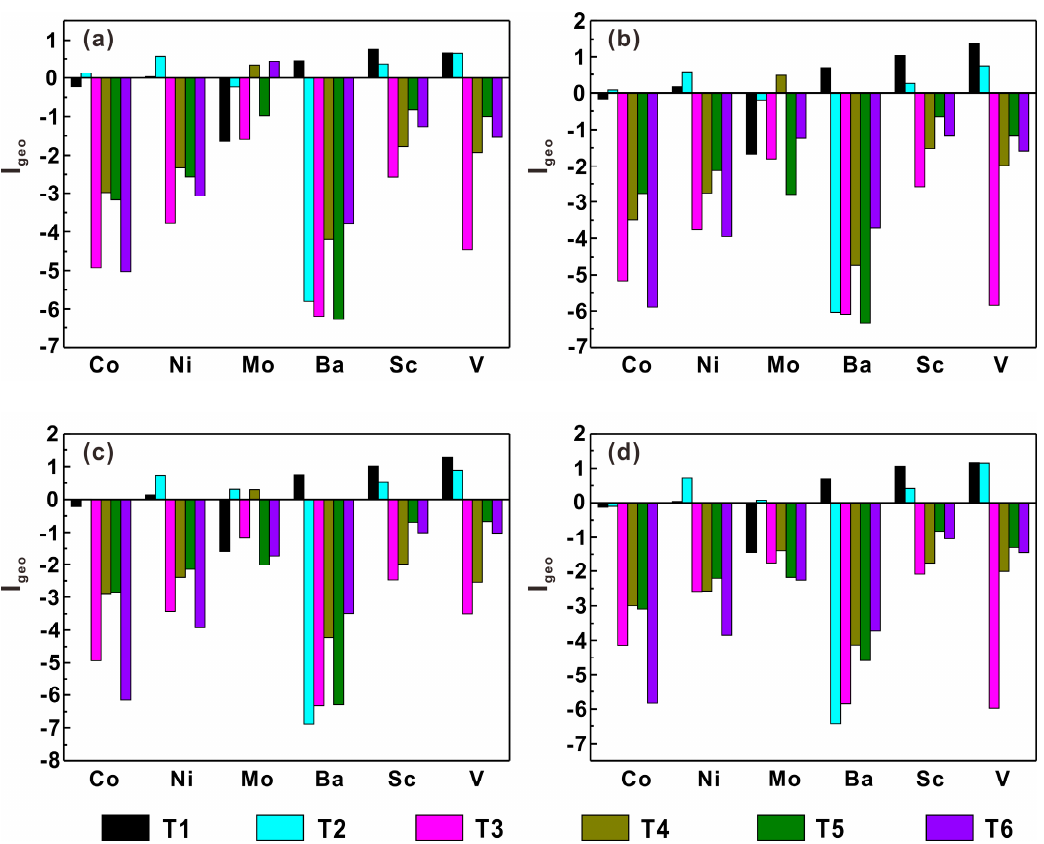
Figure 4. Geoaccumulation indexes of heavy metals in the surface layers of six soil profiles. 0–10 cm ( a ); 10–20 cm ( b ); 20–30 cm ( c ); 30–40 cm ( d ).